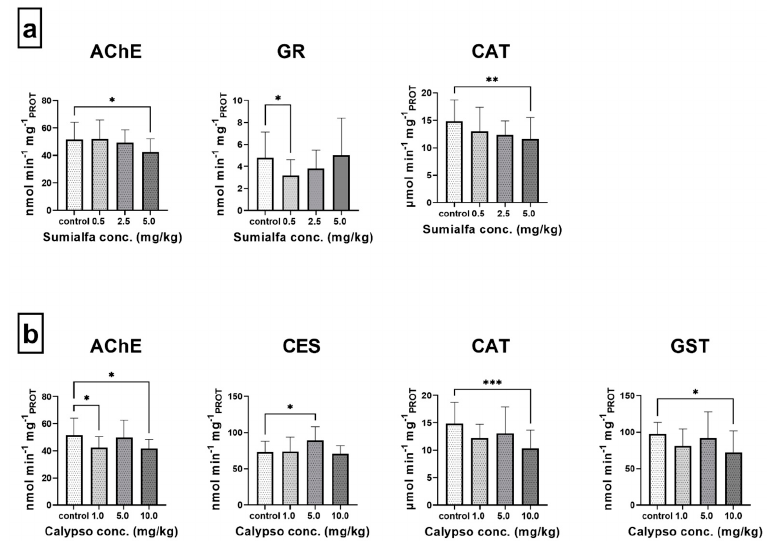
Figure 1. Biomarker responses after 48-h exposures to insecticides Calypso and Sumialfa in soil. Acetylcholinesterase (AChE), carboxylesterase (CES), glutathione S-transferase (GST), glutathione reductase (GR), and catalase (CAT) activities measured in E. andrei earthworms exposed to the com- mercial pesticide preparations ( a ) Sumialfa (active ingredient esfenvalerate) and ( b ) Calypso (active ingredient thiacloprid) for 48 h in LUFA 2.2 soil. Results are presented as mean ± standard deviation ( n = 20) and only significant differences (* p < 0.05, ** p < 0.01, and *** p < 0.001) between control and pesticide treatments are shown (ANOVA followed by Dunnett’s multiple comparison